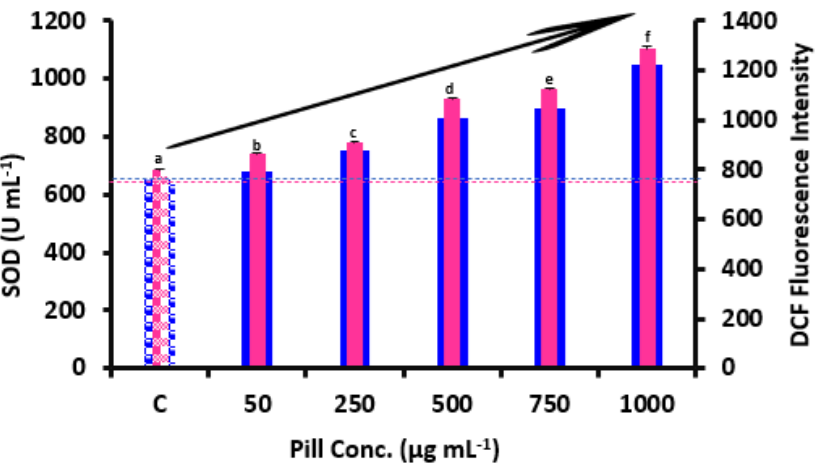
Figure 4. The impact of date seed pills on intracellular SOD action and ROS production in RAW264.7 macrophages. SOD, superoxide dismutase; ROS, reactive oxygen species. The findings are presented as means ± SD. Distinct letters reveal considerable changes at p < 0.05. Pill conc. refers to the concentration of the pill extracts used in our study, which were extracted after being formulated and formed. The same letters are insignificantly different ( p > 0.05) following the Duncan’s multiple range tests.